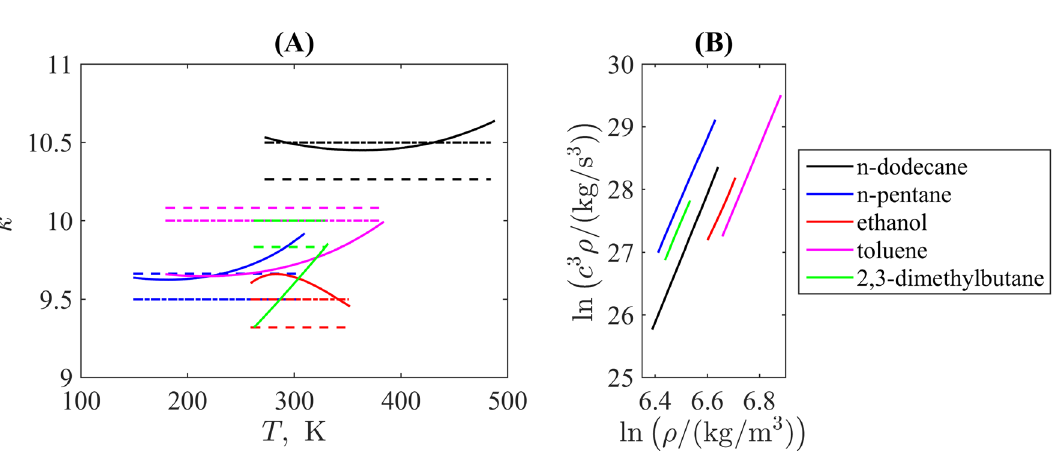
Figure 4. ( A ) Examples of the isothermal nonlinearity parameter from the triple point to the normal melting point for saturated molecular liquids of different classes, where solid lines are point-wise thermodynamic values calculated explicitly with derivatives of the fundamental equations of state included in the NIST REFPROP 30 , and the dashed lines are the average values defined as slopes of the linear fits of lines shown in ( B ). Liquids are marked by the same colours in both